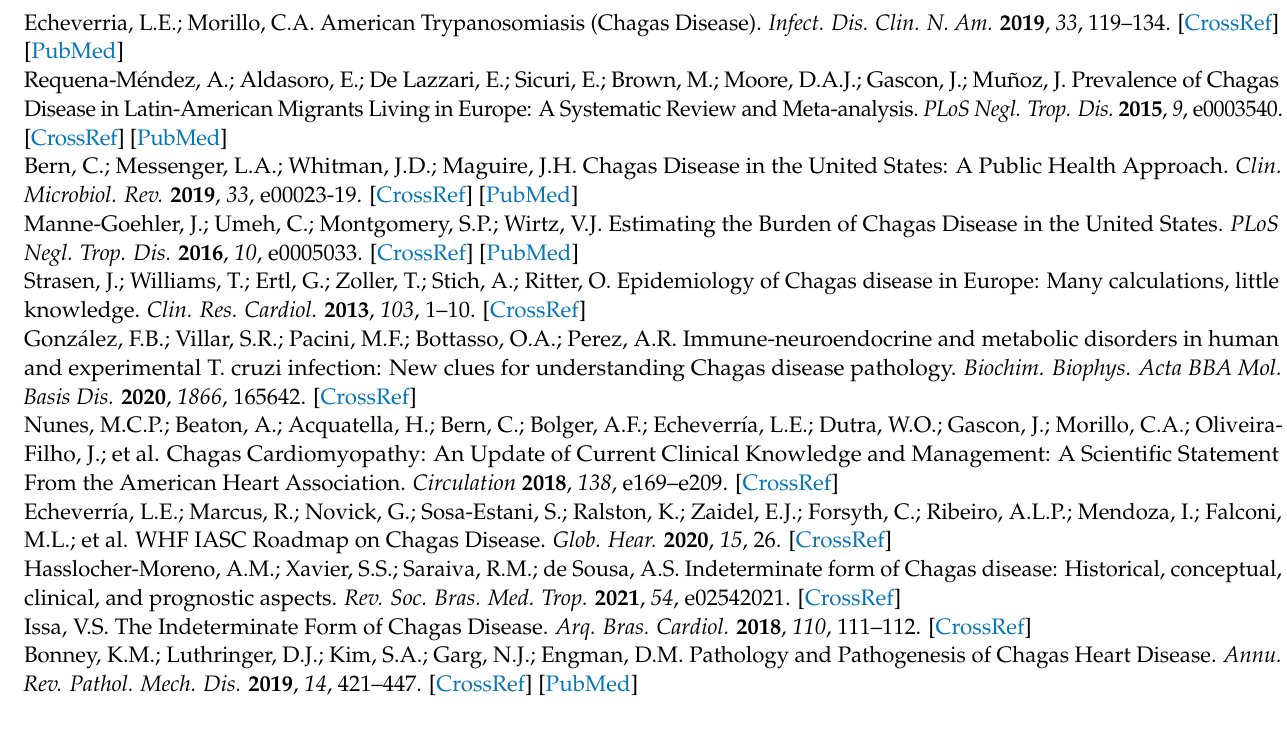
Table S2: Technical characteristics and evaluation of the reliability of the strain measurements in the included studies; Table S3: Meta-regression analysis evaluating variables associated with the global longitudinal strain in patients with the indeterminate form of Chagas Disease; Table S4: Pooled mean values of segmental longitudinal strain in patients with Chagas Disease and healthy controls; Table S5: Meta-regression analysis evaluating variables associated with the global longitudinal strain in patients with chronic Chagas cardiomyopathy; Table S6: Standardized mean differences in segmental longitudinal strain between patients with Chronic Chagas Cardiomyopathy, Indeterminate Form patients, and Healthy Con-trols; Table S7: Sensitivity analysis assessing longitudinal strain differences between patients with Chronic Chagas Cardiomyopathy, Indeterminate Form patients, and healthy controls us-ing mean differences; Table S8. Methodological quality of included studies; Box S1. Search